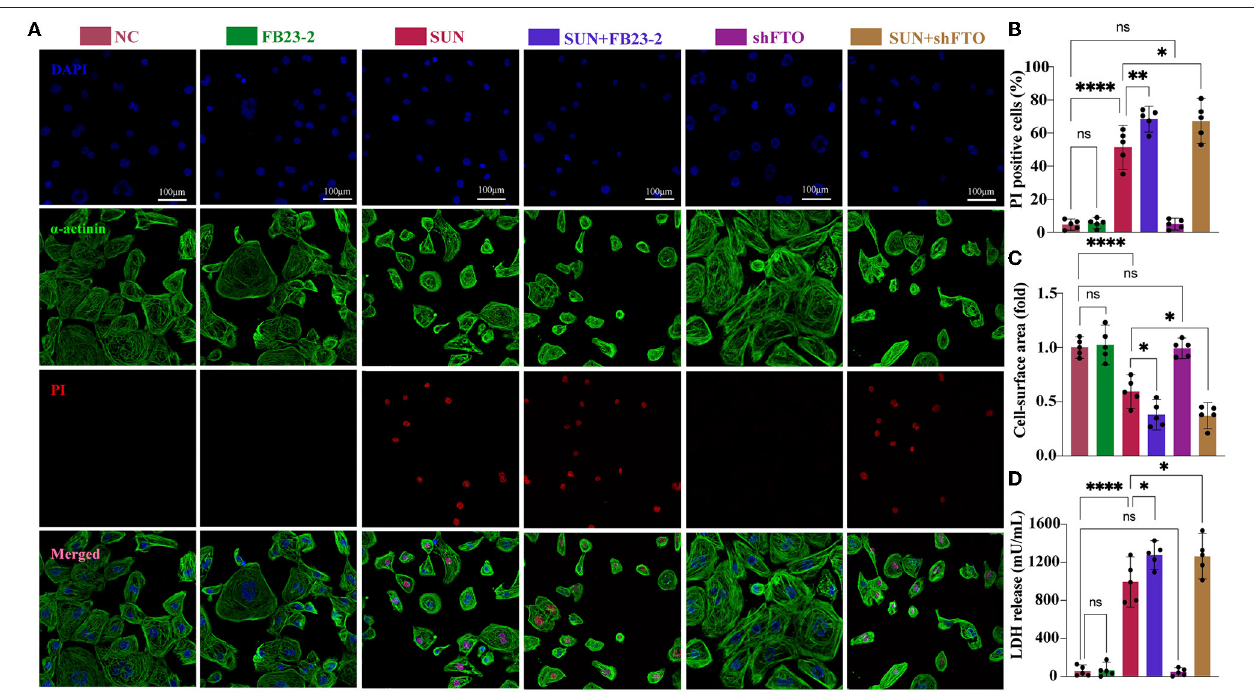
FIGURE 6 | The FTO inhibitor FB23-2 and knocking down of FTO aggravated SUN-induced hiPSC-CM injury. (A) Multiple immunofluorescences staining of DAPI (blue), propidium iodide (PI) (red), and α -actinin (green) to detect hiPSC-CM death. (B) The proportions of PI-positive cardiomyocytes ( n = 5). (C) The cell surface area was detected and analyzed by CellProfiler pipeline ( n = 5). (D) Measurement of LDH release levels ( n = 5). NS, non-significant, “*” indicates p < 0.05, “**” indicates p < 0.01, and “****” indicates p <